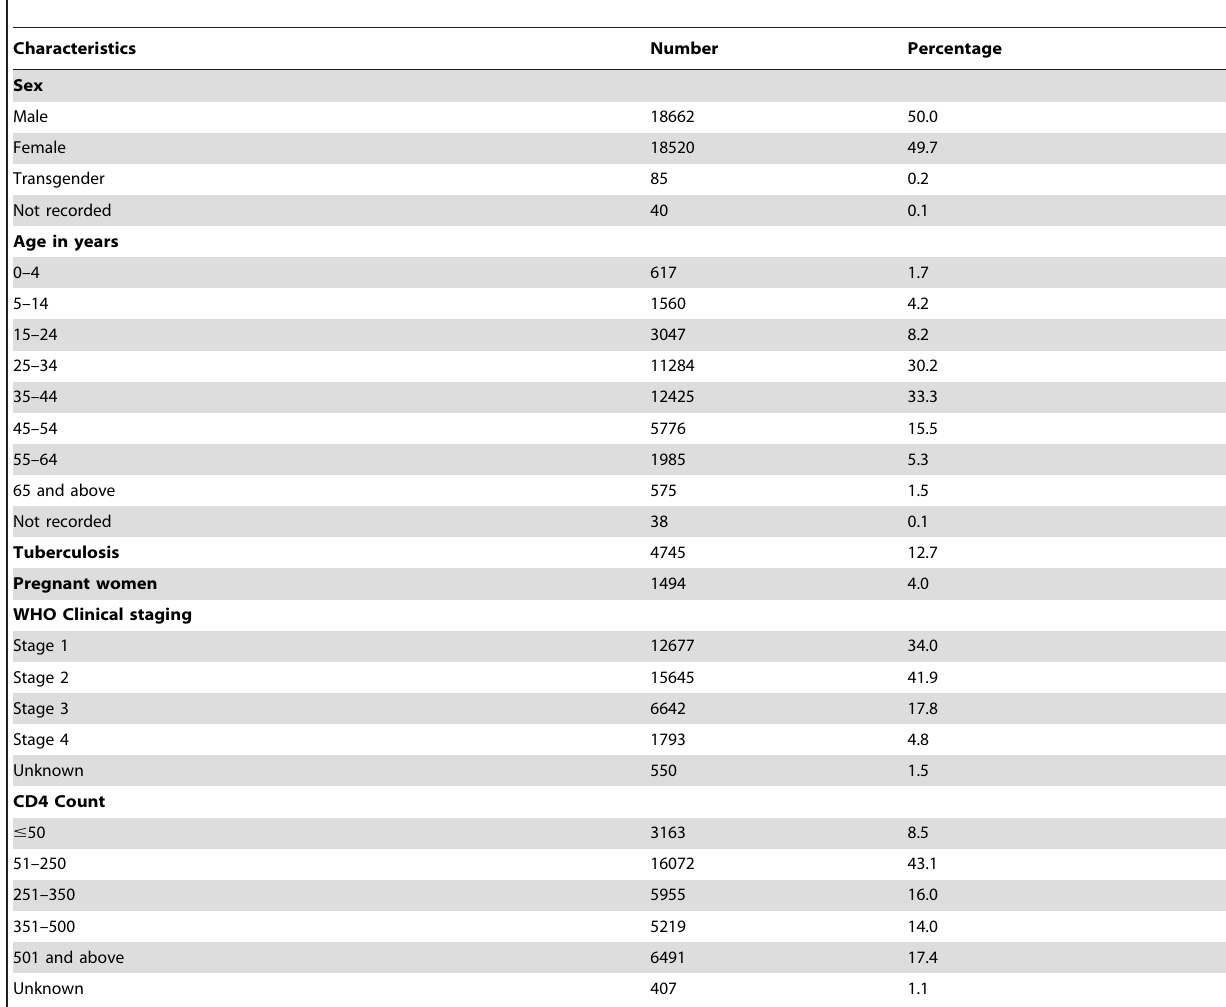
Table 2. Demographic and clinical characteristics of HIV infected people registered for pre-ART care in Karnataka State, India, 2012 (N= 37307).